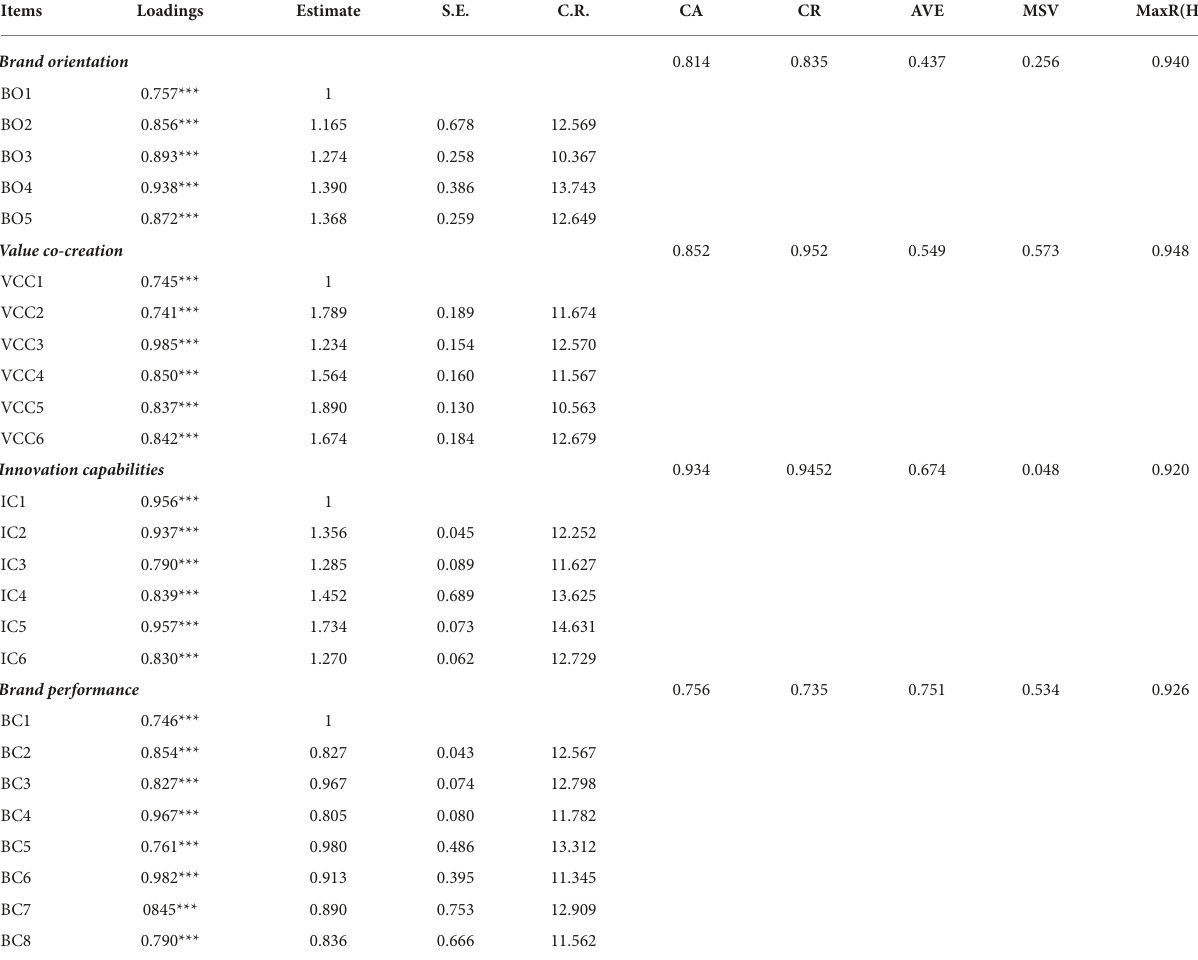
TABLE 1 Confirmatory factor analysis